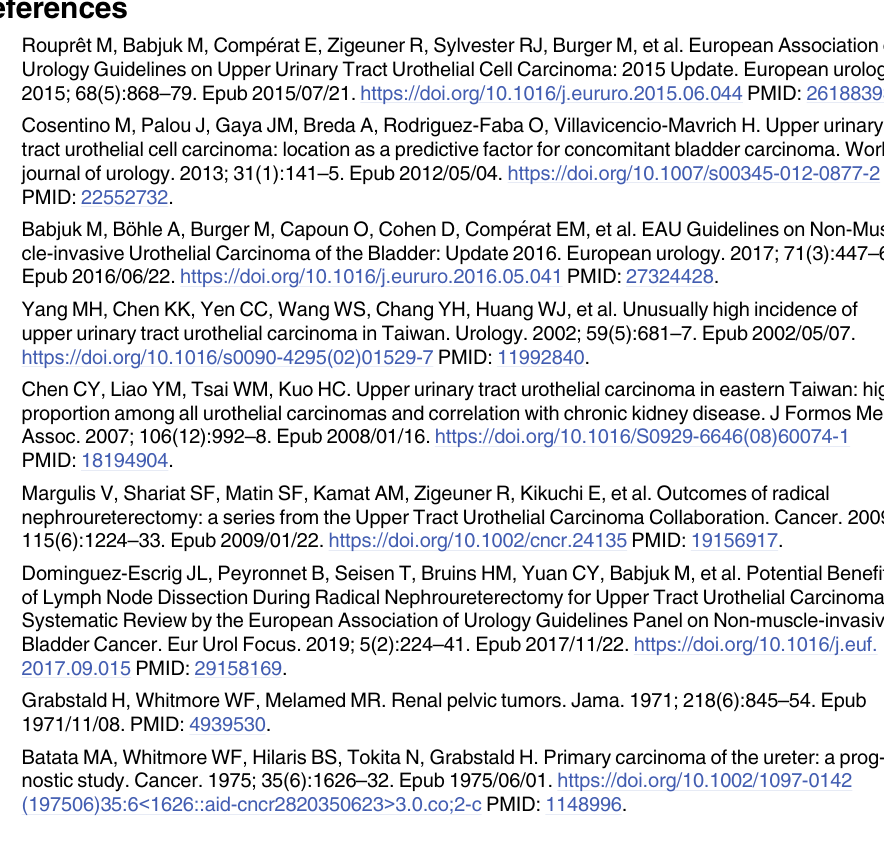
S2 Table. The CSS for three patient groups. Kaplan-Meier analysis of CSS for 520 patients with pathologically proved lymph node status (pN1–3 and pN0) or without LND (pNx) in cN0 UTUC undergoing RNU with BCE. S3 Table. The OS for three patient groups. Kaplan-Meier analysis of OS for 520 patients with pathologically proved lymph node status (pN1–3 and pN0) or without LND (pNx) in cN0 UTUC undergoing RNU with